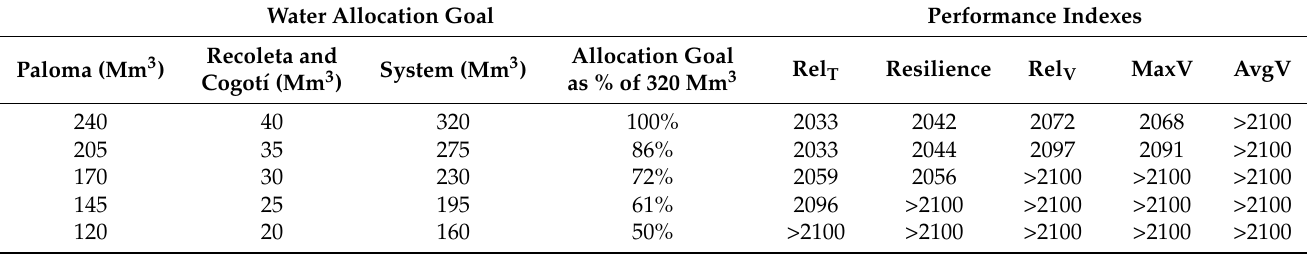
Table 4. First year in which, for different allocation goal reductions, the 50th percentile reservoir performance exceeds a 10% worse-than-the-reference value with no turning back under RCP 8.5. Columns 1 and 2 show annual allocation goals for each reservoir, and columns 3 and 4 show the corresponding system allocation goal as volume and as a percentage of the original 320 Mm 3